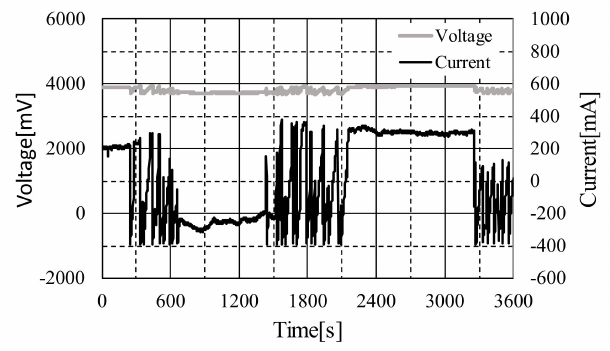
Figure 13. Voltage and current waveform during charging / discharging process on the proposed MTC with a constant load.